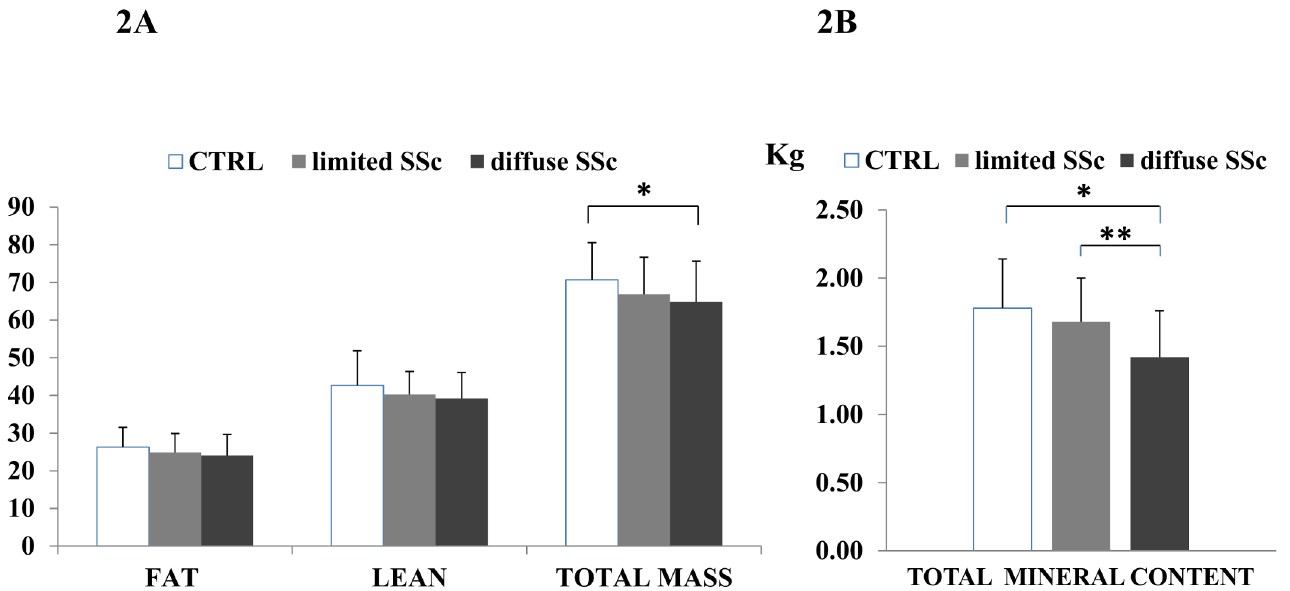
Fig 2. Analysis of body mass composition in healthy post-menopausal women and patients with diffuse and limited SSc subsets (fat, lean and total mass and total mineral content). 2A. No differences in fat mass and lean mass are observed between healthy control group, limited and diffuse cutaneous subsets of SSc; total body mass was significantly lower in dcSSc patients compared to healthy controls ( * p < 0,05). Patients with dcSSc also show a slightly lower total body mass compared to lcSSc which do not reach statistical significance. 2B. No difference in total mineral content is observed between healthy subjects and lcSSc patients, whereas total mineral content was significantly lower in dcSSc compared to both control group ( * p < 0,001) and lcSSc group ( ** p < 0,01).